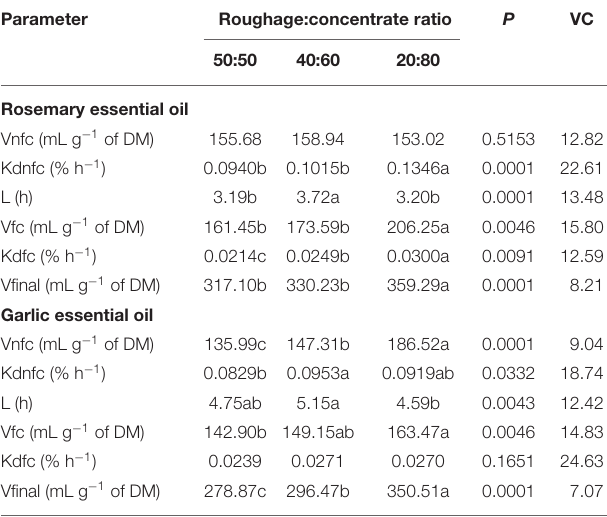
TABLE 3 | Carbohydrate degradation kinetics in lambs fed diets with different roughage:concentrate ratios containing garlic and rosemary essential oils. Parameter Roughage:concentrate